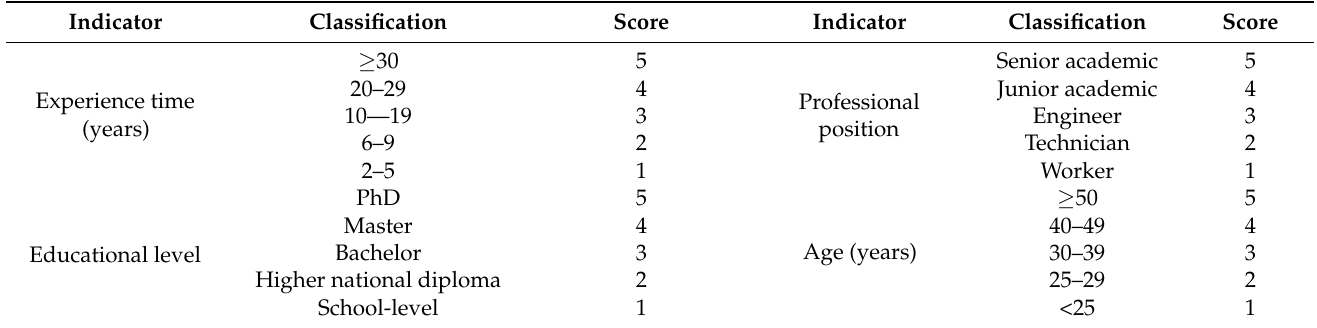
Table 2. Weight scores of different experts.